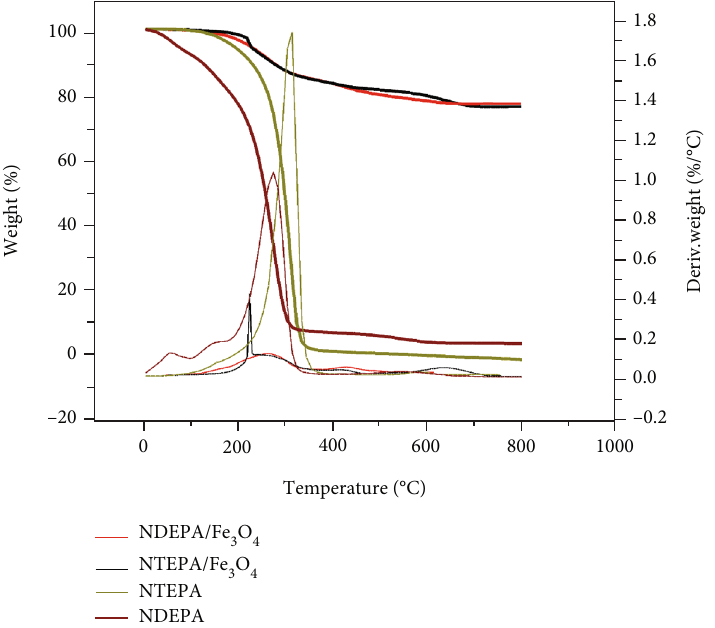
Figure 7: TGA thermograms of NTEPA/Fe